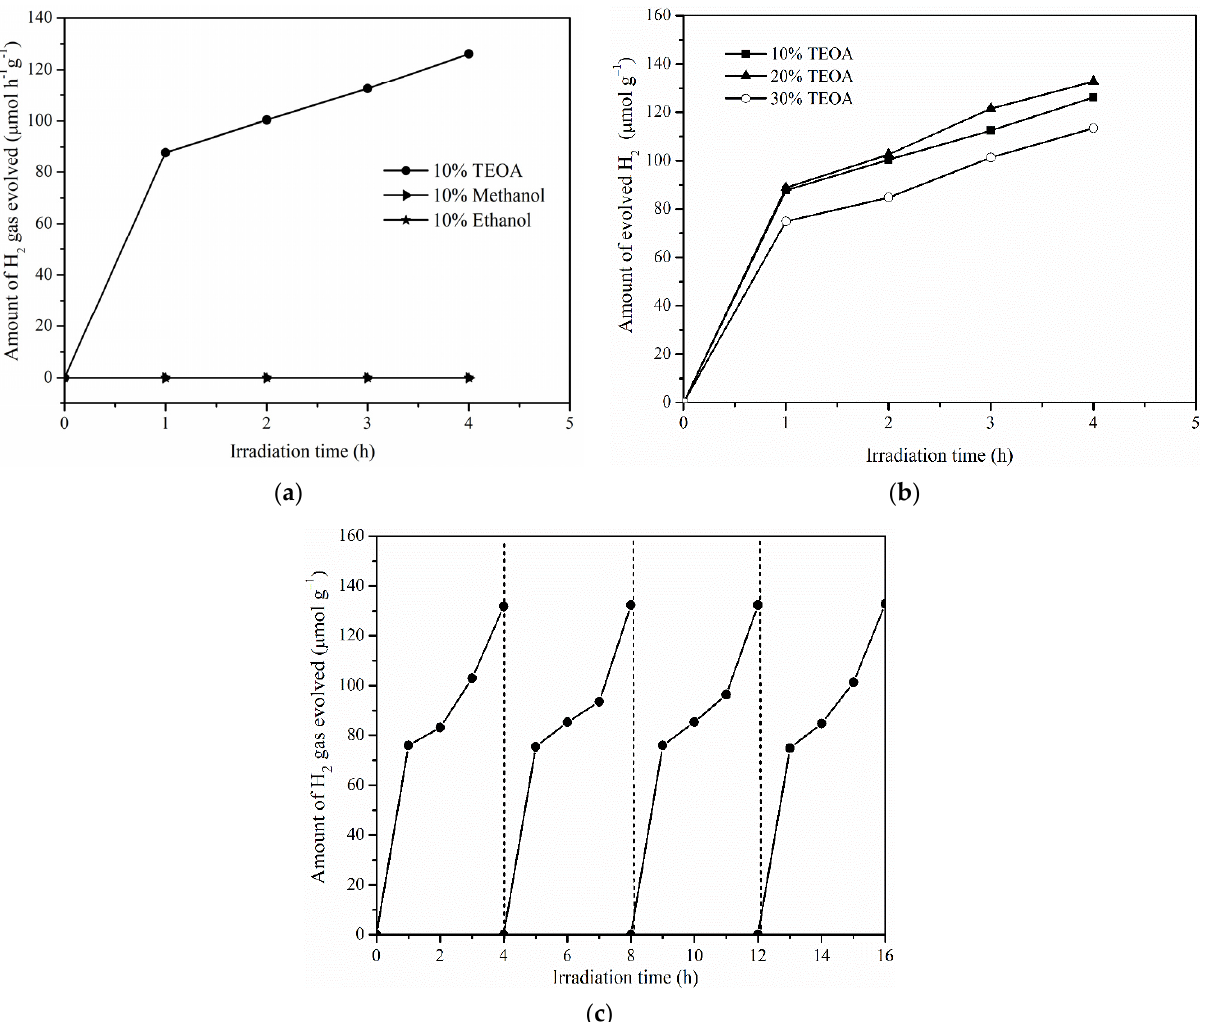
Figure 12. ( a ) Photocatalytic activity of RhCrO x /Pr-LaFeO 3 with different sacrificial reagents and ( b ) different concentrations of TEOA. ( c ) Cyclic water splitting using RhCrO x /Pr-LaFeO 3 photocatalysts.